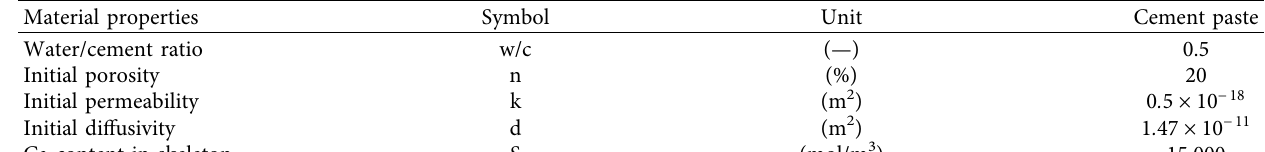
Figure 6: Model configuration and boundary conditions. Table 2: Main material properties assumed in Gawin’s simulation [35].